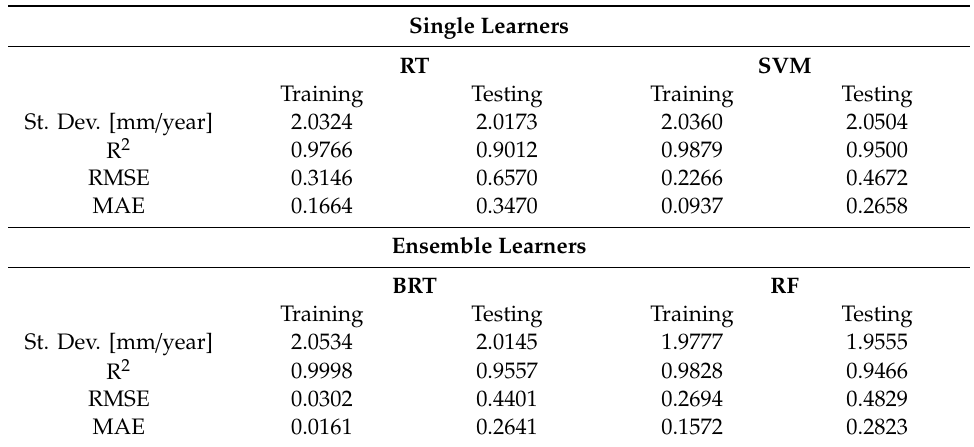
Table 5. Goodness-of-Fit and Predictive Performance of the Machine Learning Algorithms